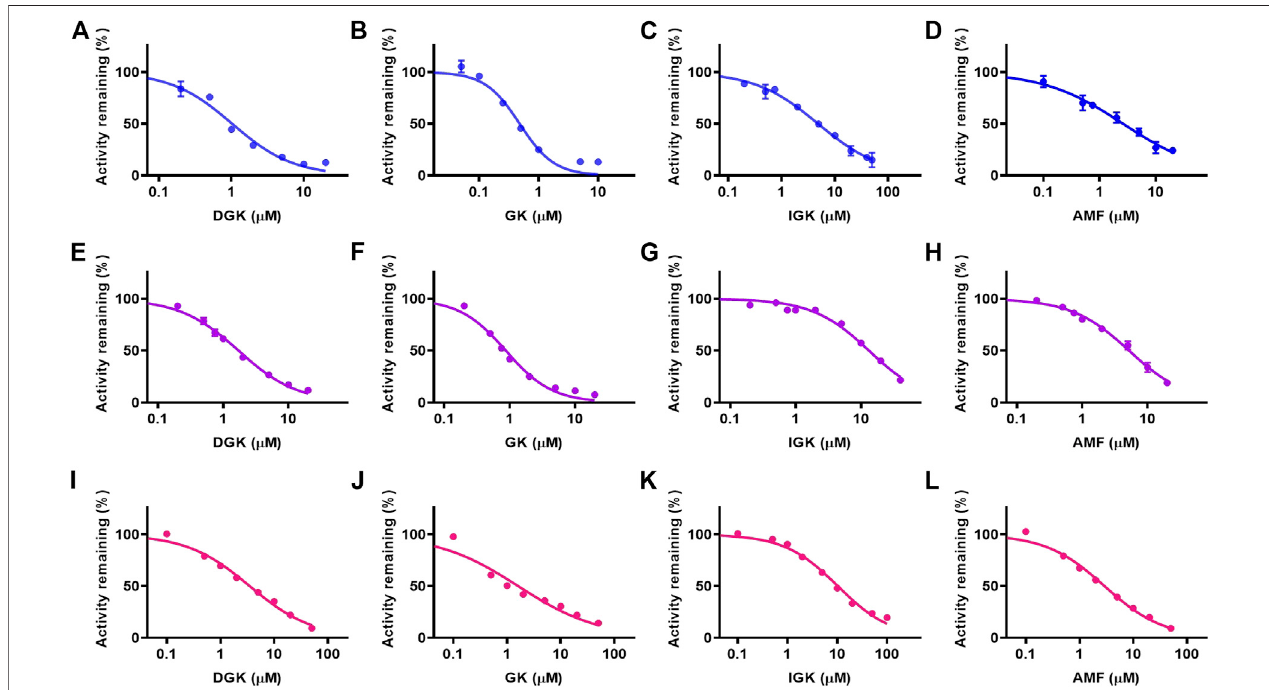
FIGURE5| Theconcentration-dependentinhibitoryeffectsoffouridenti fi edbi fl avonesagainstCYP3A4-mediatedoxidationoftamoxifen (A – D) ,ge fi tinib (E – H) and ticagrelor (I – L) in HLM. (A, E, I) DGK, (B, F, J) GK, (C, G, K) IGK, (D, H, L) AMF. Data are shown as the mean ± S.D. ( n = 3). Each line represents the line of best fi t to the data.